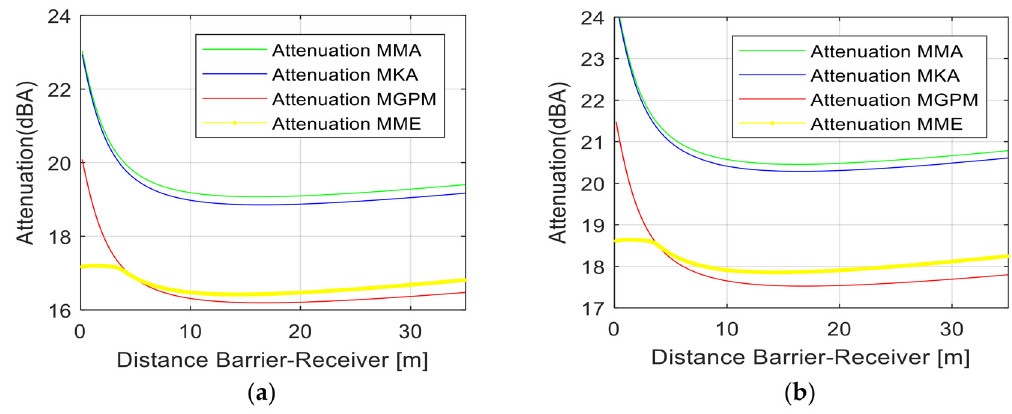
Figure 7. Sound attenuation as a function of the distance barrier-receiver and for a pure tone: σ e = 104 kPa · s · m − 2 . ( a ) Frequency = 2000 Hz, ( b ) frequency = 2500